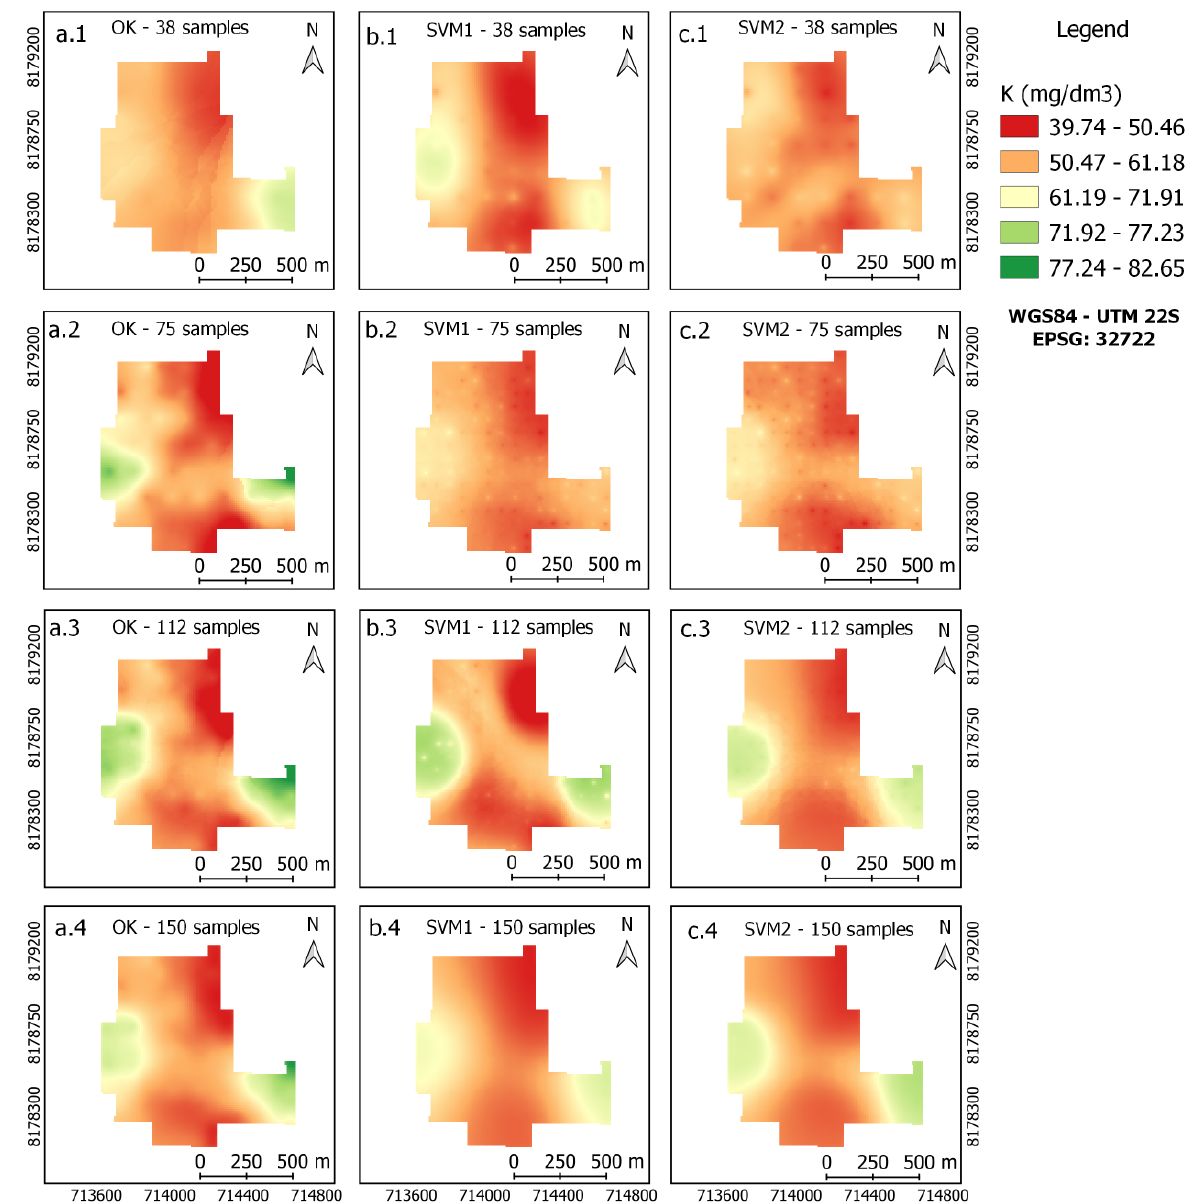
Figure 10. Maps obtained by interpolation of Potassium (K + ): ( a ) OK, ( b ) SVM1 , ( c ) SVM2 ; Set of points (training): 38 ( a.1 – c.1 ), 75 ( a.2 – c.2 ), 112 points ( a.3 – c.3 ), and 150 points ( a.4 – c.4 ) .